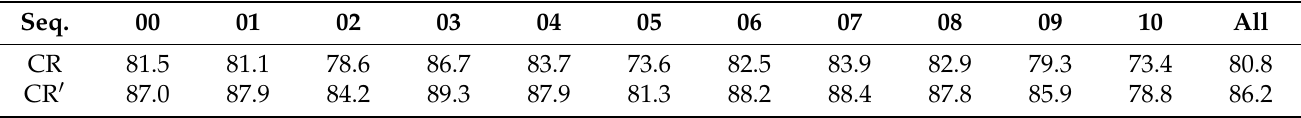
Table 3. Ratio of correctly labeled grid cells for the stereo vision